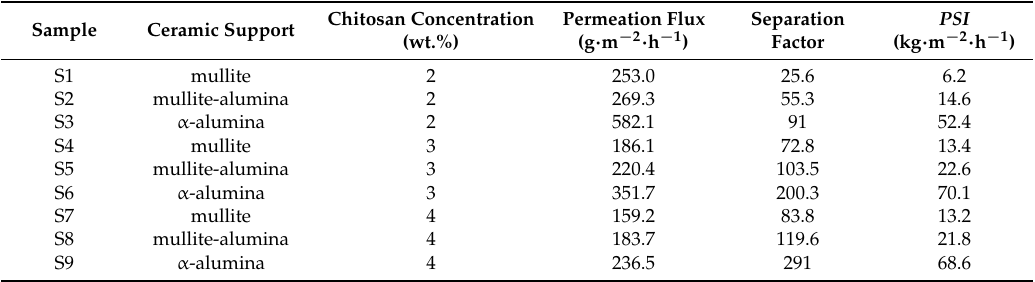
Table 3. The results of ethanol dehydration pervaporation process at a temperature of 60 °C and a 90% concentration of ethanol in the feed.